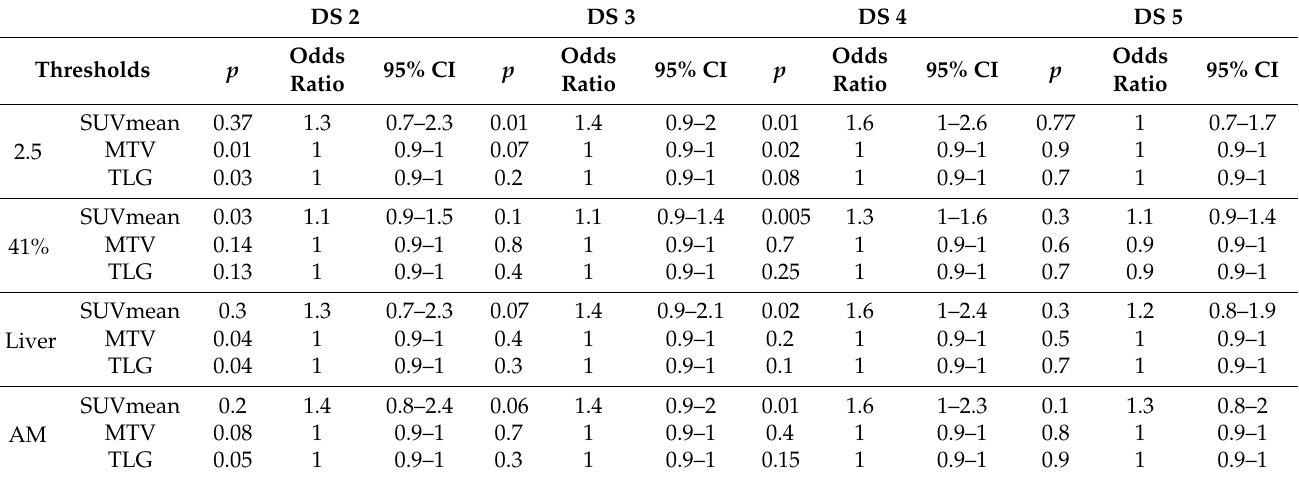
Table 4. Logistic regression of different baseline threshold values with respect to post-treatment